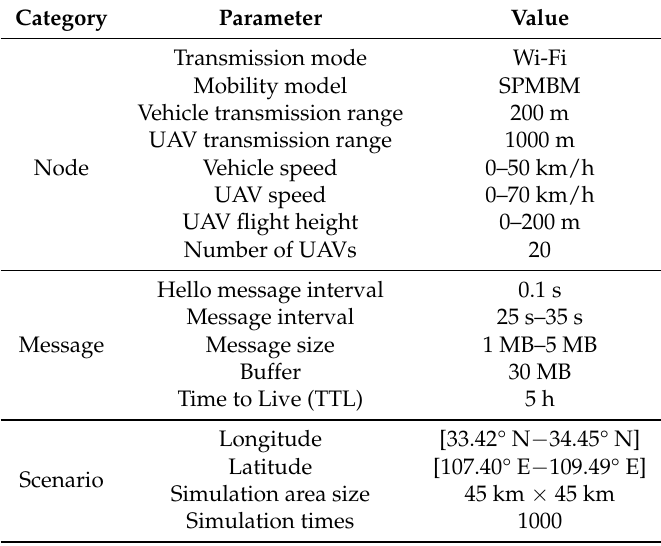
Table 1. Simulation